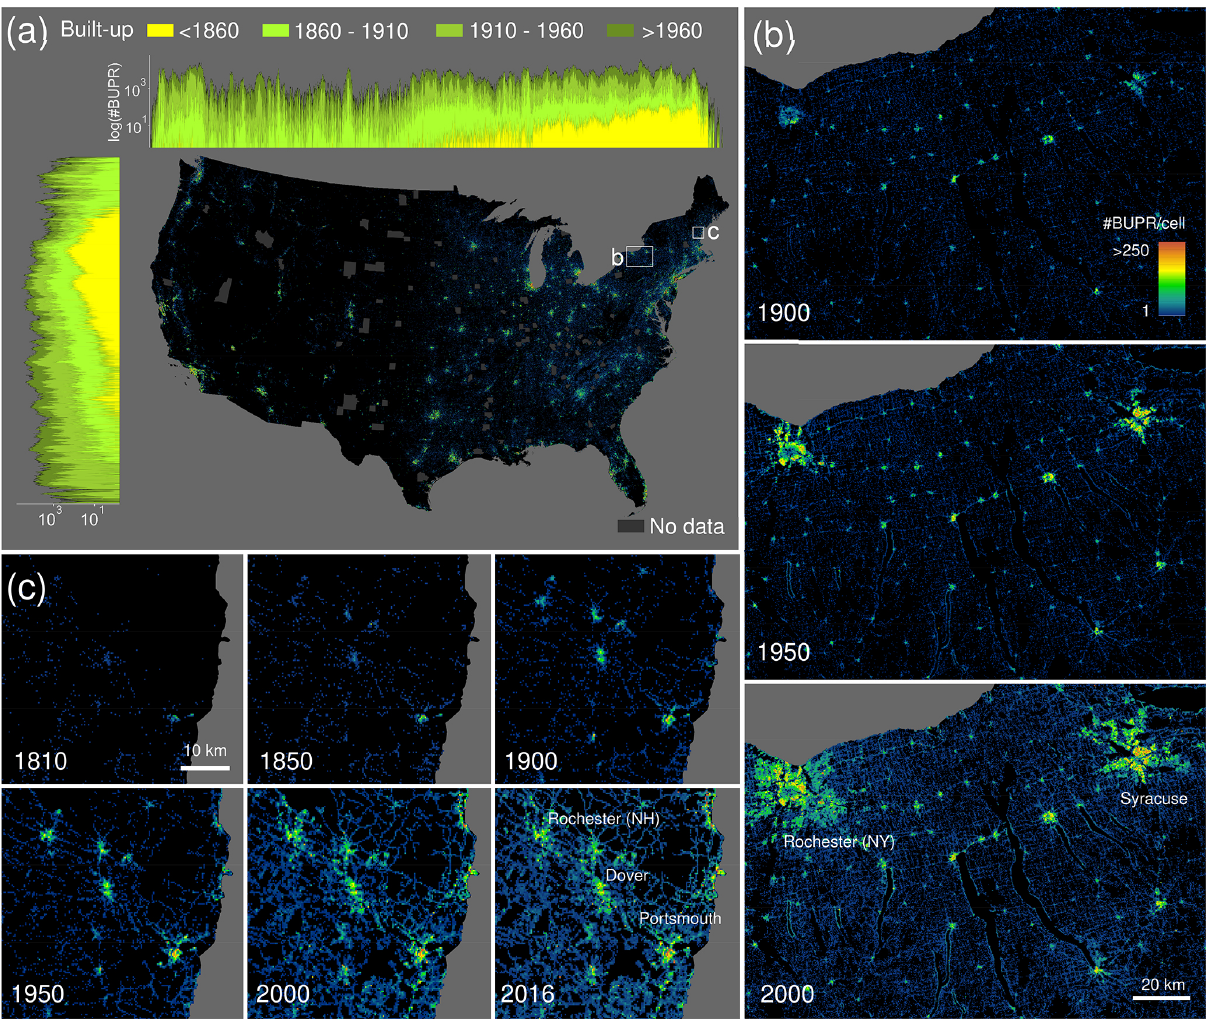
Figure 1. Fine-resolution time series of gridded building data for the USA: (a) contemporary (2016) built-up property records (BUPRs) in the USA, including log-transformed directional (i.e. north–south and east–west) histograms for different time periods; also shown are counties of missing data; (b) BUPR time series in mixed urban–rural context shown for the Syracuse–Rochester region (New York) for 1900, 1950, and 2000; and (c) long-term BUPR time series covering the whole time period 1810–2016 showing early settlements in New Hampshire and their development